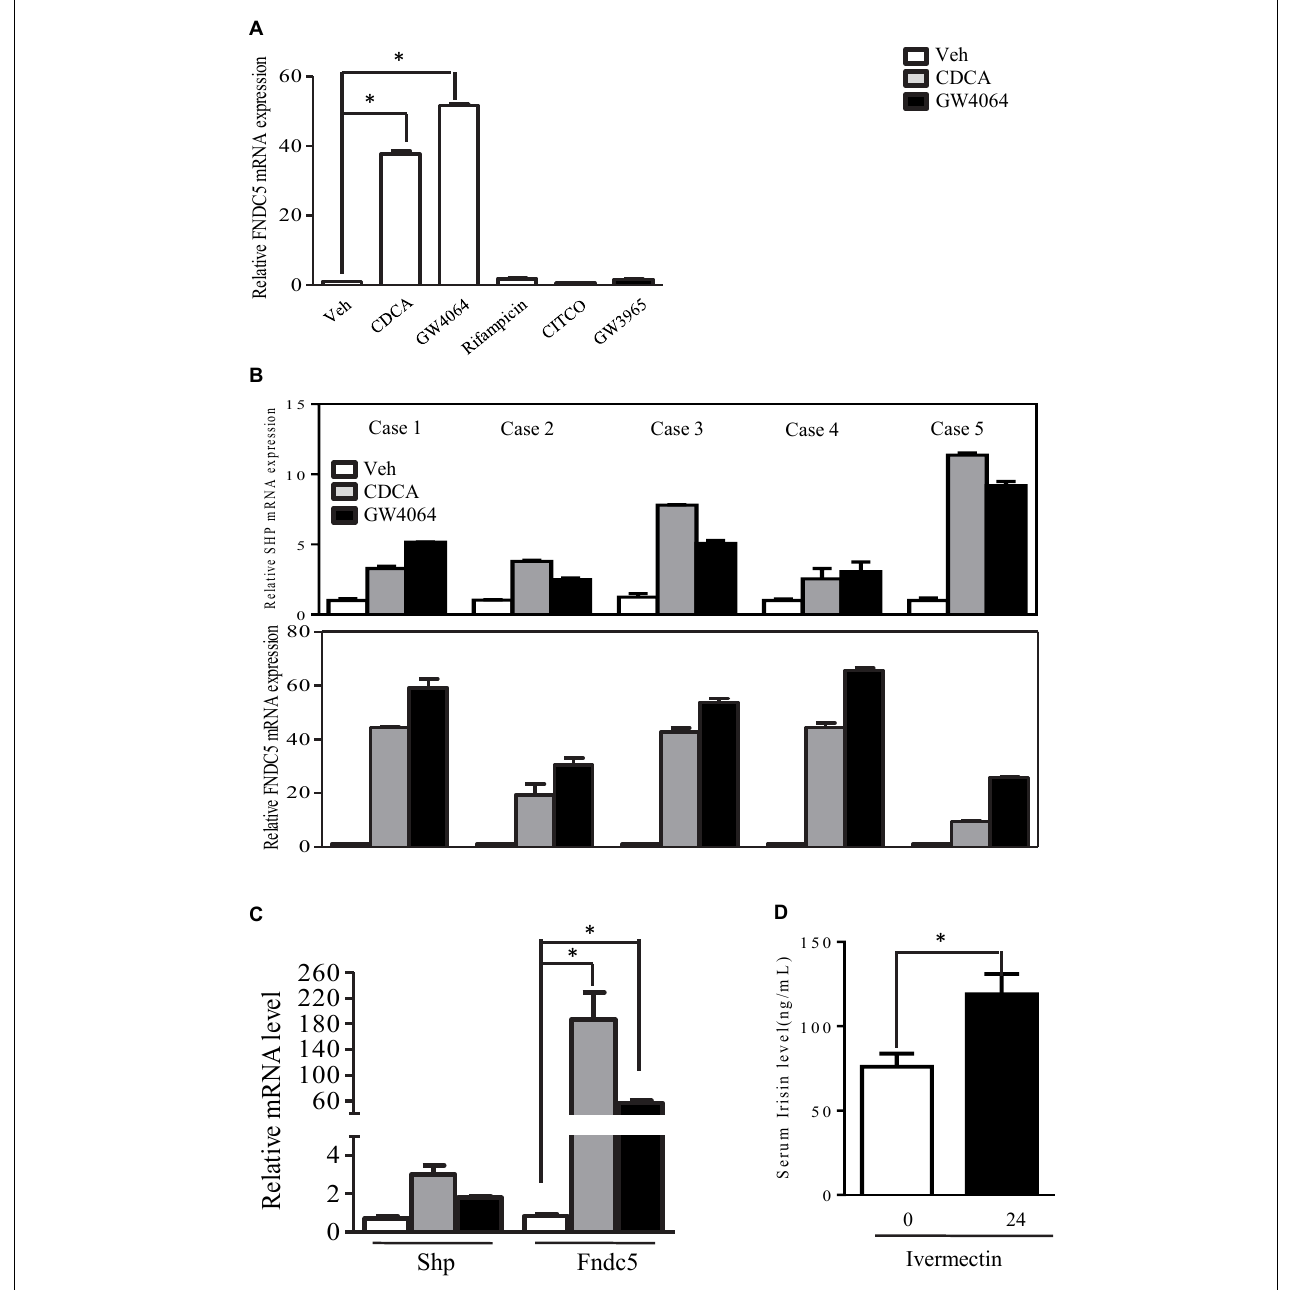
FIGURE 1 | Activation of farnesoid X receptor (FXR) regulates fibronectin type III domain-containing protein 5 (FNDC5) expression. (A) Cultured human hepatocytes were treated with different nuclear receptor agonists: CDCA (100 µ M) and GW4064 (2.5 µ M), agonists for FXR; Rif (5 µ M), an agonist for human PXR; CITCO (100 nM), an agonist for human CAR; and GW (10 µ M), an agonist for liver X receptor α (LXR α ) ( n = 3) for 24 h. (B) FXR agonist induced (small heterodimer partner) SHP and fibronectin type III domain-containing protein 5 (FNDC5) mRNA expression in cultured human hepatocytes from 5 different cases. (C) HepG2 cells were treated with CDCA (100 µ M) or GW4064 (2.5 µ M) for 24 h ( n = 4). (D) Rhesus macaques were subcutaneously injected with single dose of ivermectin (0.4 mg/kg) and blood was collected 24 h later ( n = 8). CDCA, chenodeoxycholic acid; Rif, rifamycin; GW, GW3965. Data are mean ± SEM ( n = 4). ∗ P < 0.05.